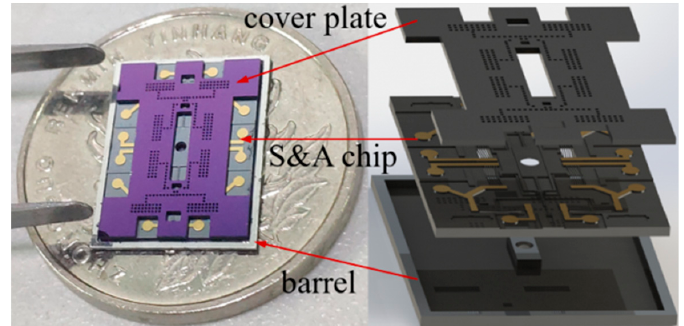
Figure 1. The structure of on-chip microelectromechanical systems (MEMS) based Safety and Arming Device (SAD).